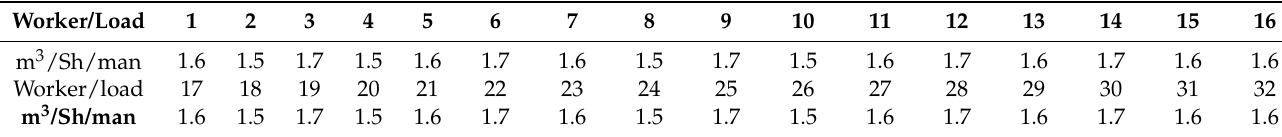
Table 5. Masonry works—performance m 3